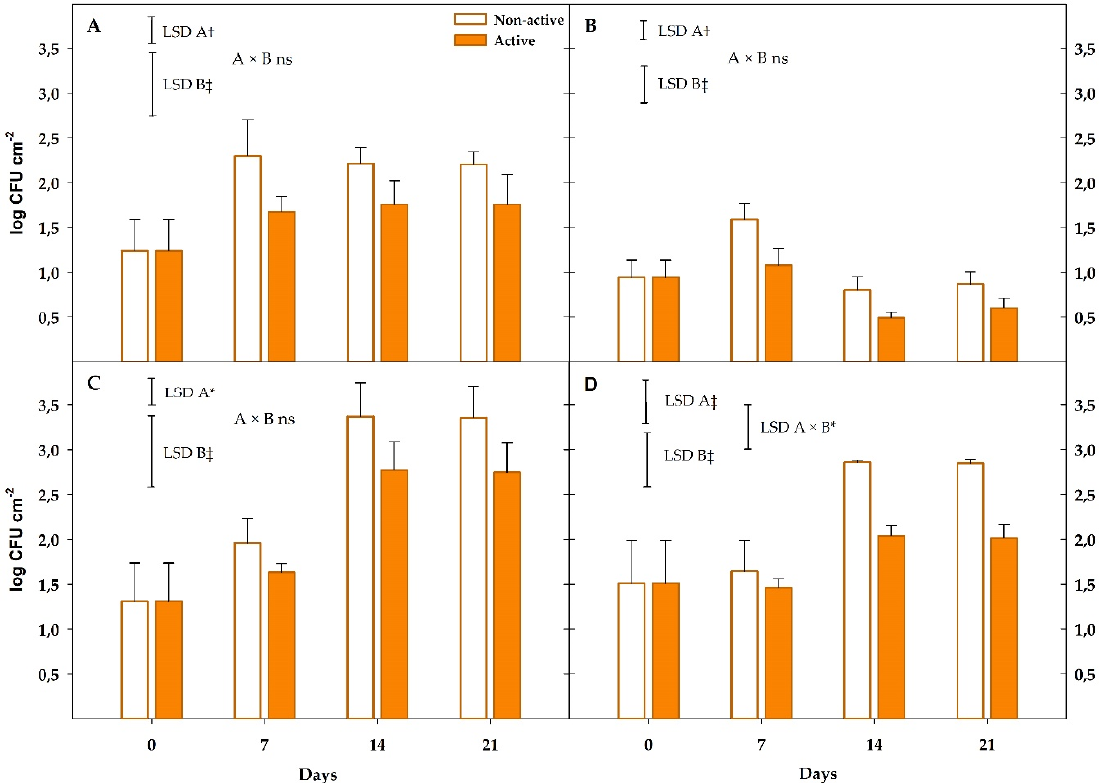
Figure 6. Microbial loads ( A ), mesophiles; ( B ), enterobacteria; ( C ), moulds; ( D ), yeasts of mandarins packaged within non-active and active package up to 21 days at 8 °C ( n = 3, ± SD). Least significant differences (LSD) are represented with bars. The uppercase letters A and B denote package type and storage time, respectively. ns, not significant ( p > 0.05). *, † and ‡ significance for p ≤ 0.05, 0.01 and 0.001, respectively.